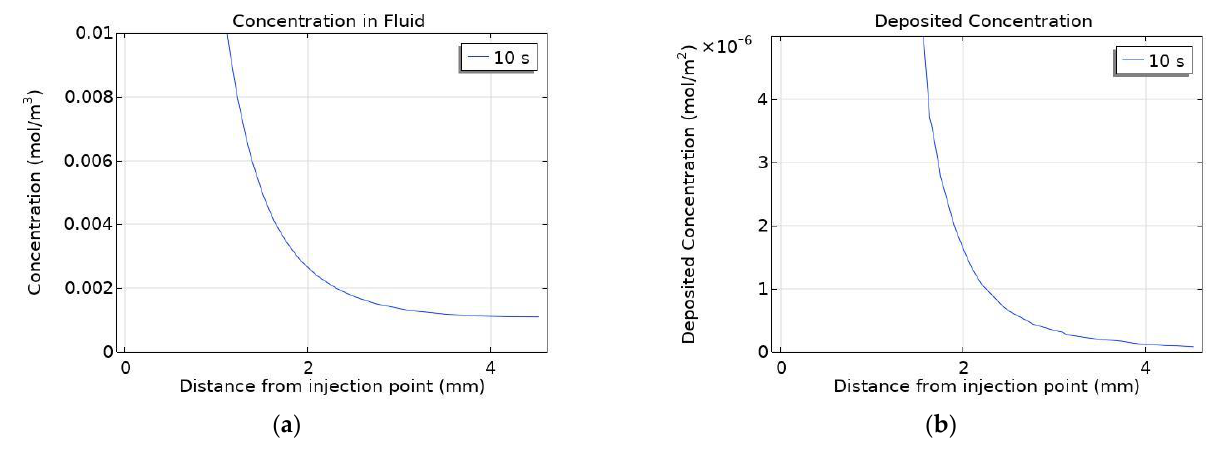
Figure 6. Close-up of concentration cut lines of positively charged nanoparticles: ( a ) within the fluid; ( b ) deposited onto cell surfaces.